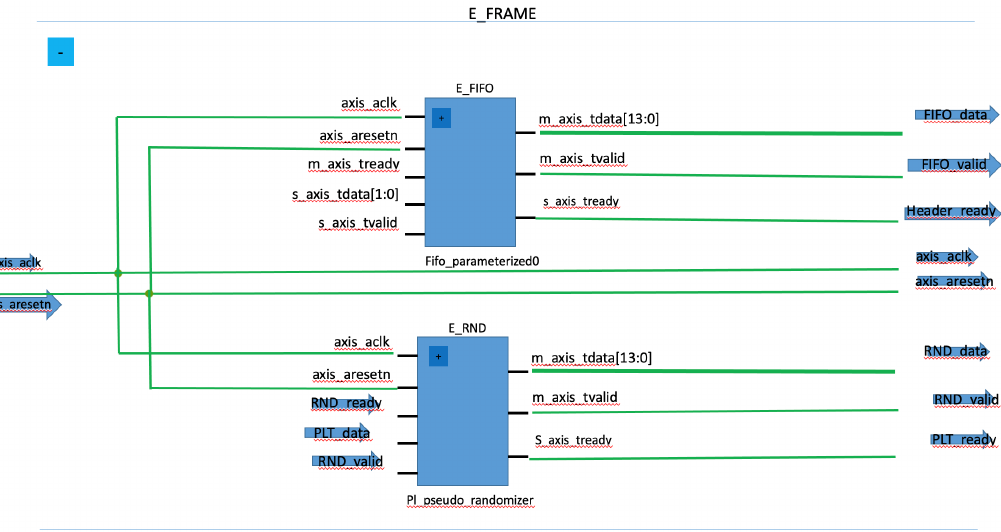
Figure 18. PART II—physical layer frame RTL block